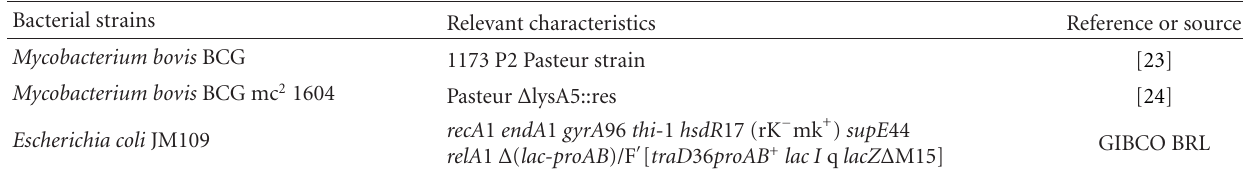
Table 1: List of bacterial strains used in this study.